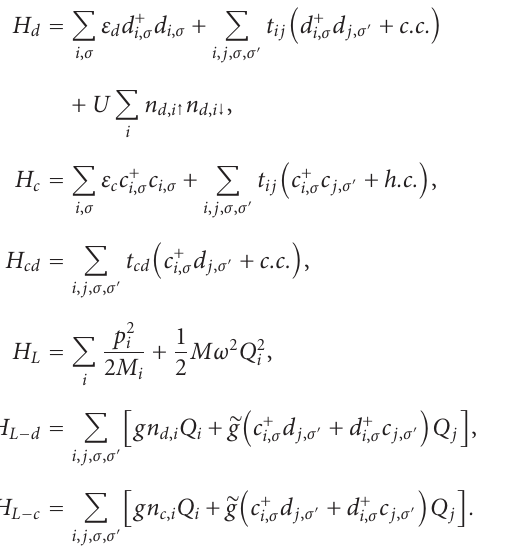
momentum and conjugate displacement coordinates with frequency ω and M the ionic mass. In order to decouple lattice and electronic degrees of freedom a Lang-Firsov canonical transformation